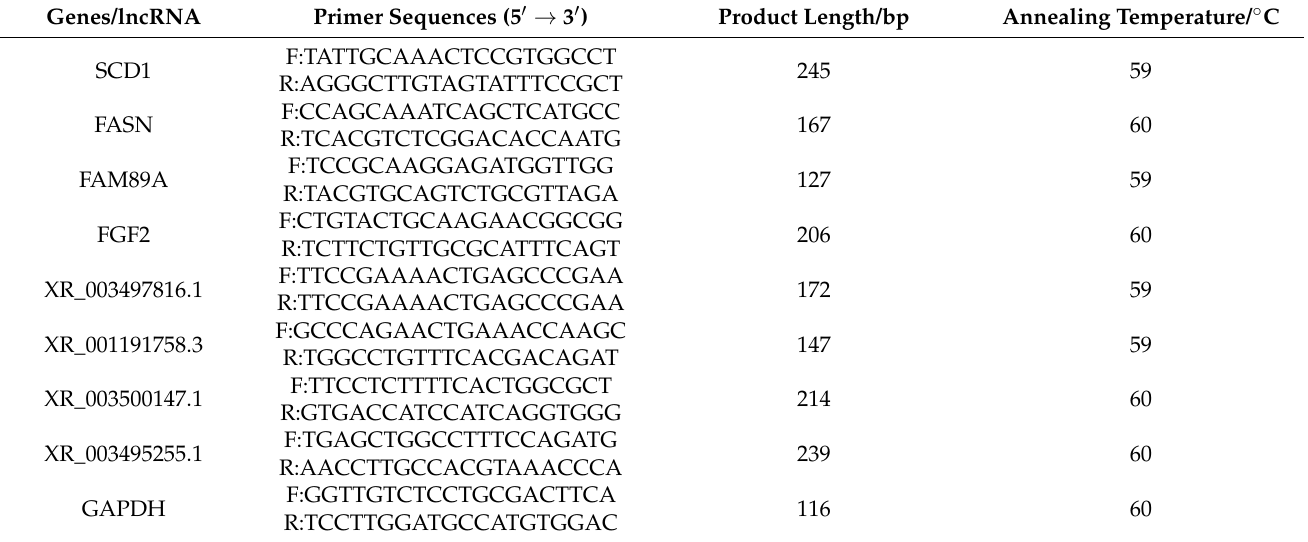
Table 1. Primer information.